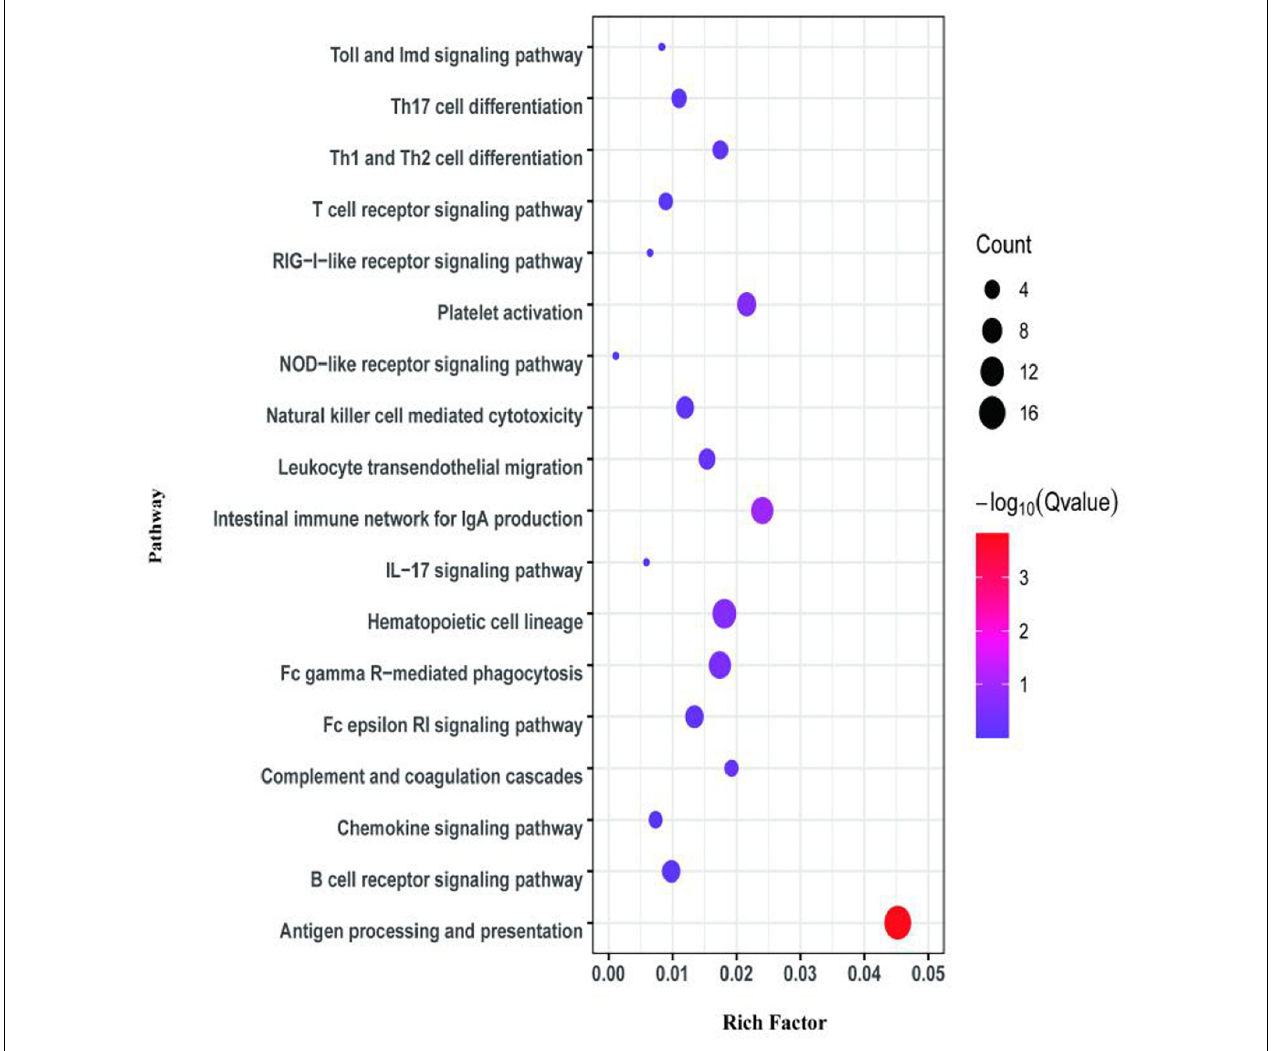
FIGURE 5 | Kyoto Encyclopedia of Genes and Genomes (KEGG) pathway enrichment analysis for differentially expressed mRNAs (DEMs) of transcriptome at 3 dpi.